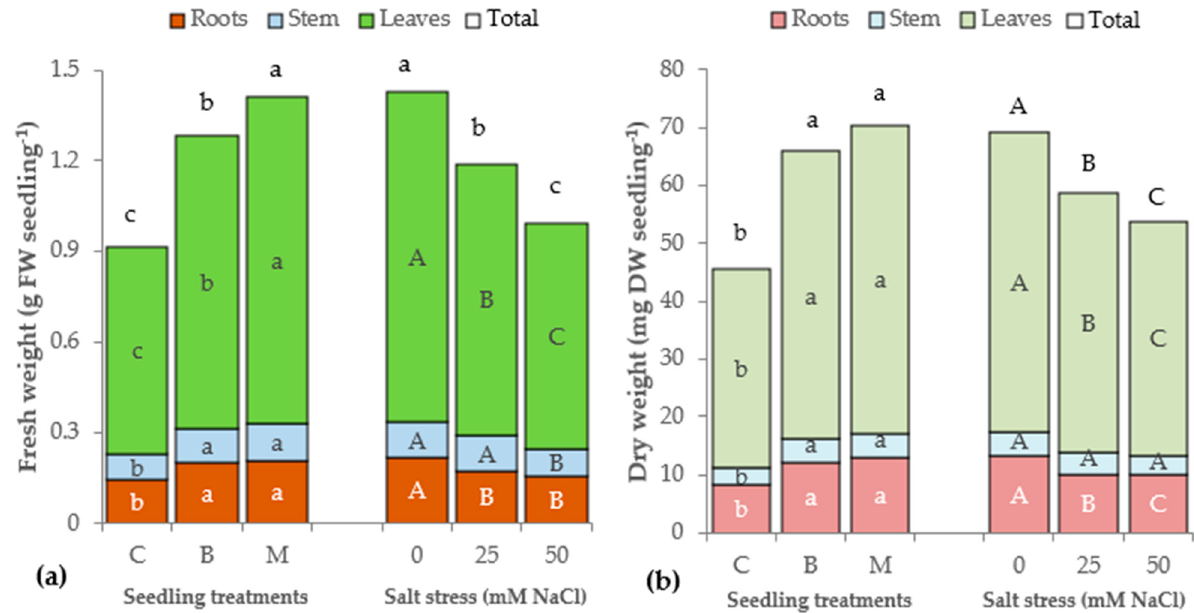
Figure 2. Effect of microbial biostimulant treatments (C, untreated control; B, Bactorr S13 ; M, Flortis Micorrize) and salt stress (0, 25, and 50 mM NaCl in the irrigation water) on the total, root, stem, and leaf ( a ) fresh and ( b ) dry weight of lettuce seedlings (bars of the same color with different uppercase or lowercase letters are significantly different at p < 0.05 according to the LSD test).